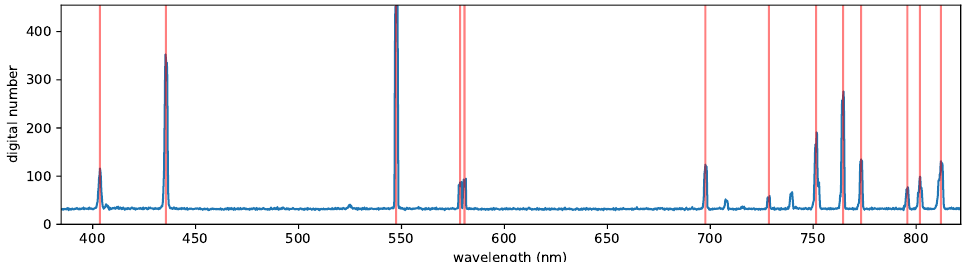
Figure 11. HgAr arc spectrum used to calibrate the wavelength scale.